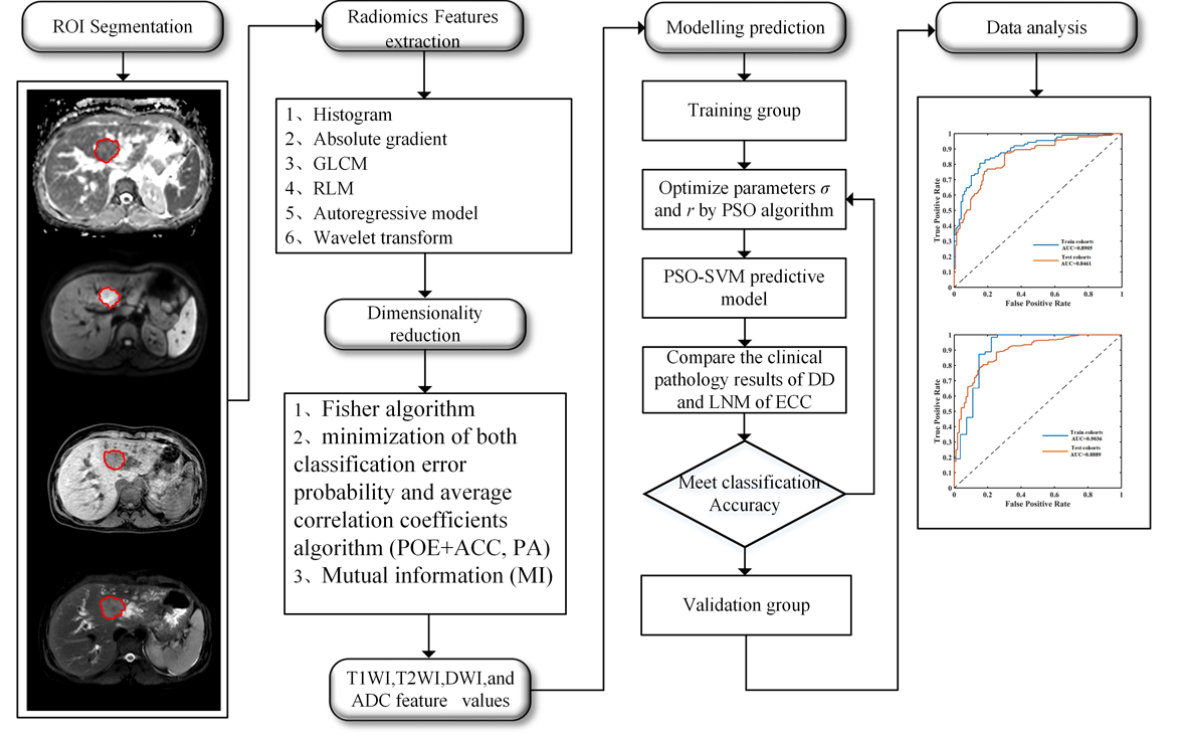
Imaging protocolAcquisition parameters